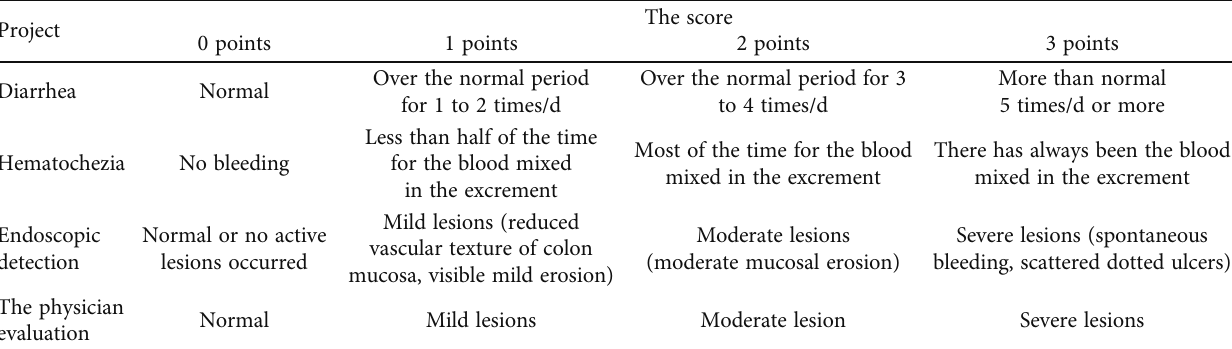
Table 1: The modi fi ed Mayo